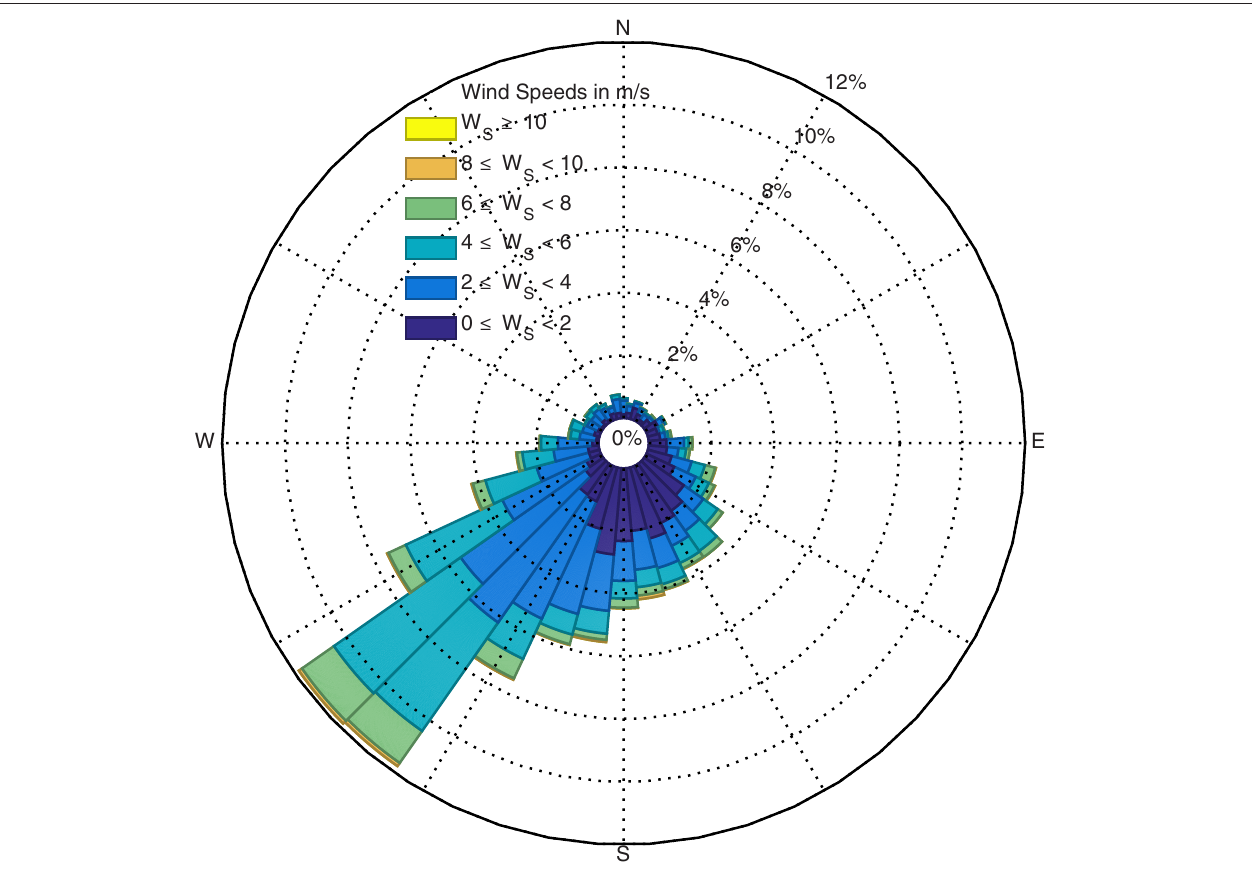
FIGURE 6 | Wind rose for CUES 2002–2015. The colors correspond to wind speeds while the polar plot shows both the direction and the frequency of the binned wind speed/direction vectors.